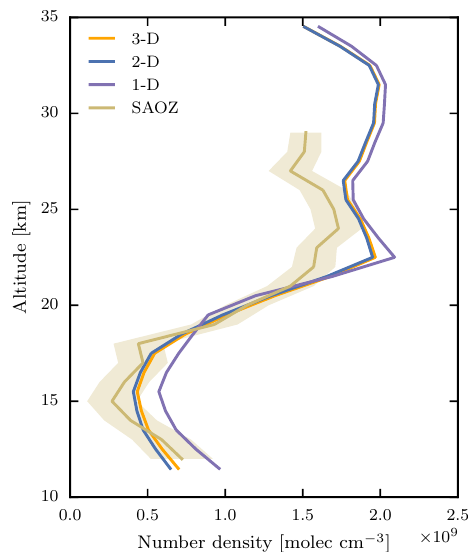
Figure 3. NO 2 profile retrieved from scan 44 of orbit 16011 us- ing the 1-D, 2-D, and 3-D retrievals, all converted to sunset (tan- gent point SZA = 90 ◦ ), the local time of coincident SAOZ mea- surements at Bauru (22.35 ◦ S, 49.03 ◦ W). OSIRIS is on the day side with SZA = 86.6 ◦ (p.m.) and an azimuth difference angle of 99 ◦ such that the far side of the limb is closer to the